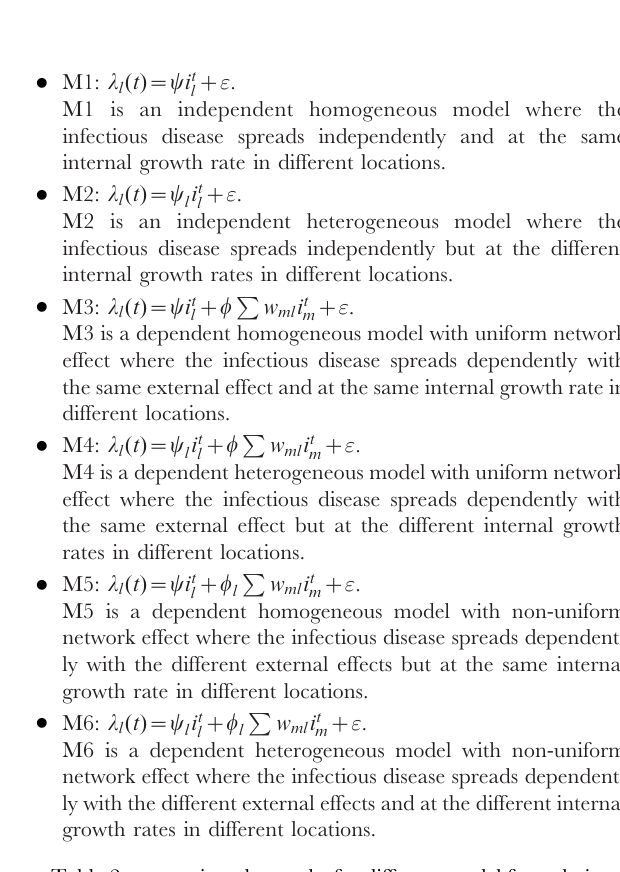
AIC BIC Log { likelihood Compared